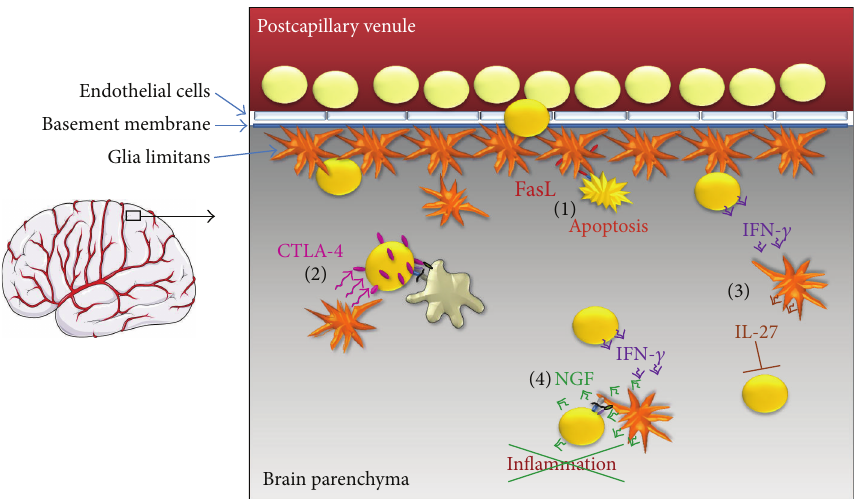
Figure 2: Astrocytes enforce the immune privilege of the CNS (left) at multiple checkpoints employing various mechanisms (right). Astrocytes in the glia limitans are responsible for the exceptional tightness of endothelial tight junctions by producing soluble factors [18]. DespitetheBBB,activatedTcells(yellow)areabletoenterthebrainparenchyma(grey)[65].(1)Atthesametime,astrocytesintheglialimitans and in the parenchyma may express FasL while activated T cells may express Fas [63, 72, 73]. The ligation of Fas and FasL induces apoptosis of T cells [71]. (2) As this does not fully eradicate infiltrating T cells, the surviving T cells may be restimulated by activated microglia presenting CNS-specific antigens on MHC-II. In the presence of astrocytes, T cells upregulate CTLA-4 [107] which upon ligation of B7 molecules induces a stop of proliferation and anergy of the T cells. (3) IFN- 𝛾 produced by invading T cells stimulates astrocytic IL-27 production which suppresses Th17 cells [120, 121, 141]. (4) During sustained T-cell-mediated inflammation, IFN- 𝛾 secreted by T cells activates astrocytes to gain the ability to present antigen on MHC-II and costimulate T cells. While this cognate interaction may exacerbate neuroinflammation, it simultaneously leads to an upregulation of NGF production that counteracts neuroinflammation [142]. Also, astrocytes acting as APCs appear to promote Th2 responses and the formation of regulatory T cells [138]. Astrocytes: orange cells; pink: effects leading to CTLA-4 upregulation; green: effects of NGF; dark red: blood; grey: brain